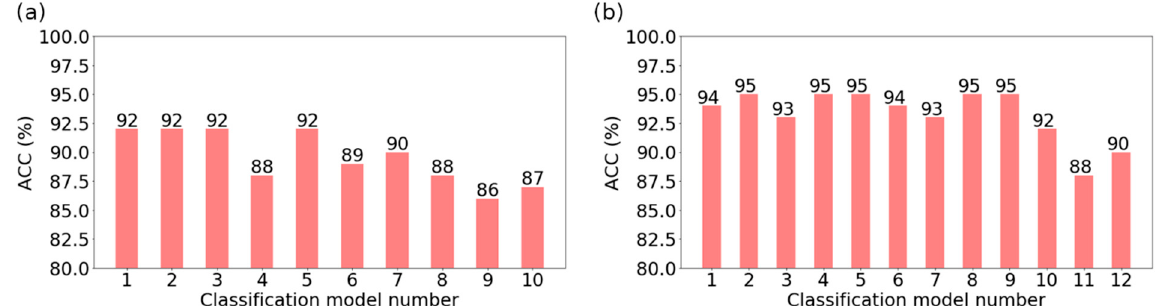
Figure 5. Results of testing the models considered optimal for particular feature selection methods: ( a ) bone reconstruction; ( b ) soft tissue reconstruction.